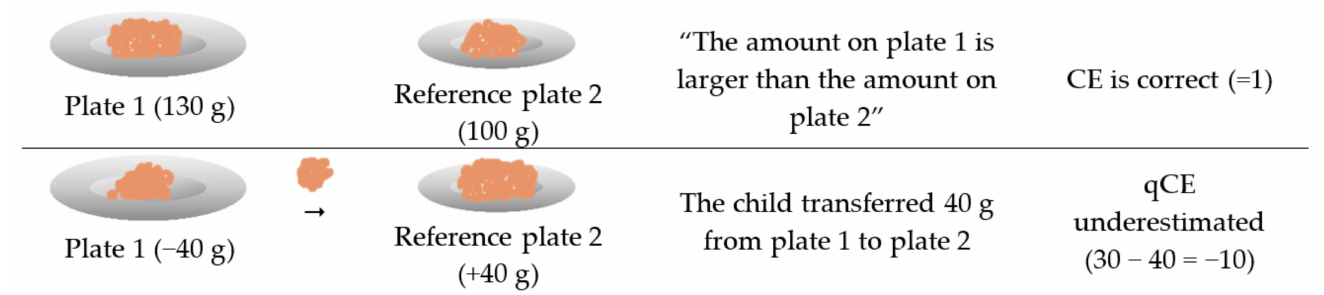
Figure 1. CE and qCE calculation shown as an example for one pair of plates. When calculating the scores, all three pairs of plates are included. Abbreviations: CE = Cognitive evaluation; qCE = Quantitative cognitive